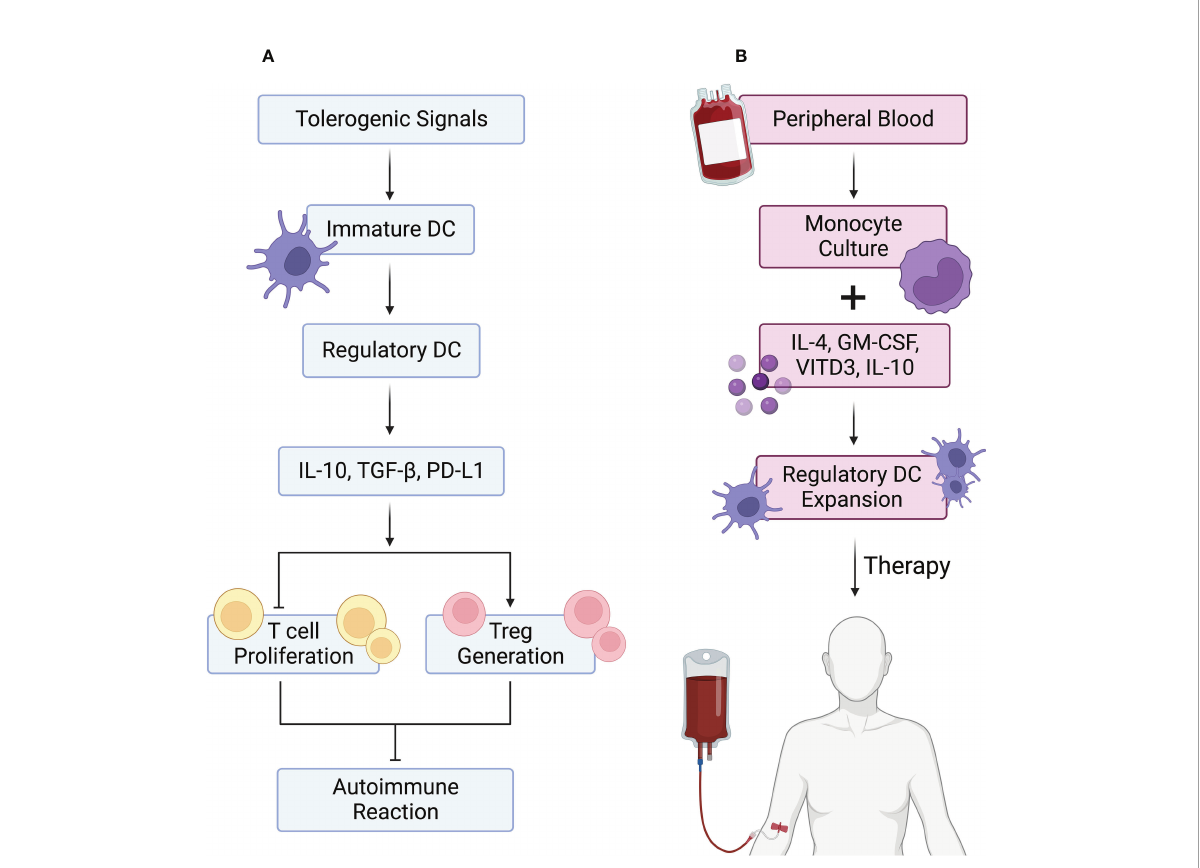
FIGURE 3 DCreg cells in autoimmune reactions and their use in autoimmune disease therapy. (A) Tolerogenic signals, including anti-in fl ammatory cytokines and apoptotic cells, lead to the differentiation of immature dendritic cells (DCs) into regulatory DCs (DCreg cells). DCreg cells are characterized by PD-L1 expression and IL-10 and TGF- b production. These properties allow DCreg cells to block effector T (Teff) cell proliferation while inducing regulatory T (Treg) cell differentiation, leading to inhibition of autoimmune reactions. (B) DCreg cells can be generated for therapy by isolating human peripheral blood monocytes and culturing them with IL-4, GM-CSF, vitamin D3 (vit D3), and IL-10. The resulting DCreg cells are then expanded in vitro and infused into